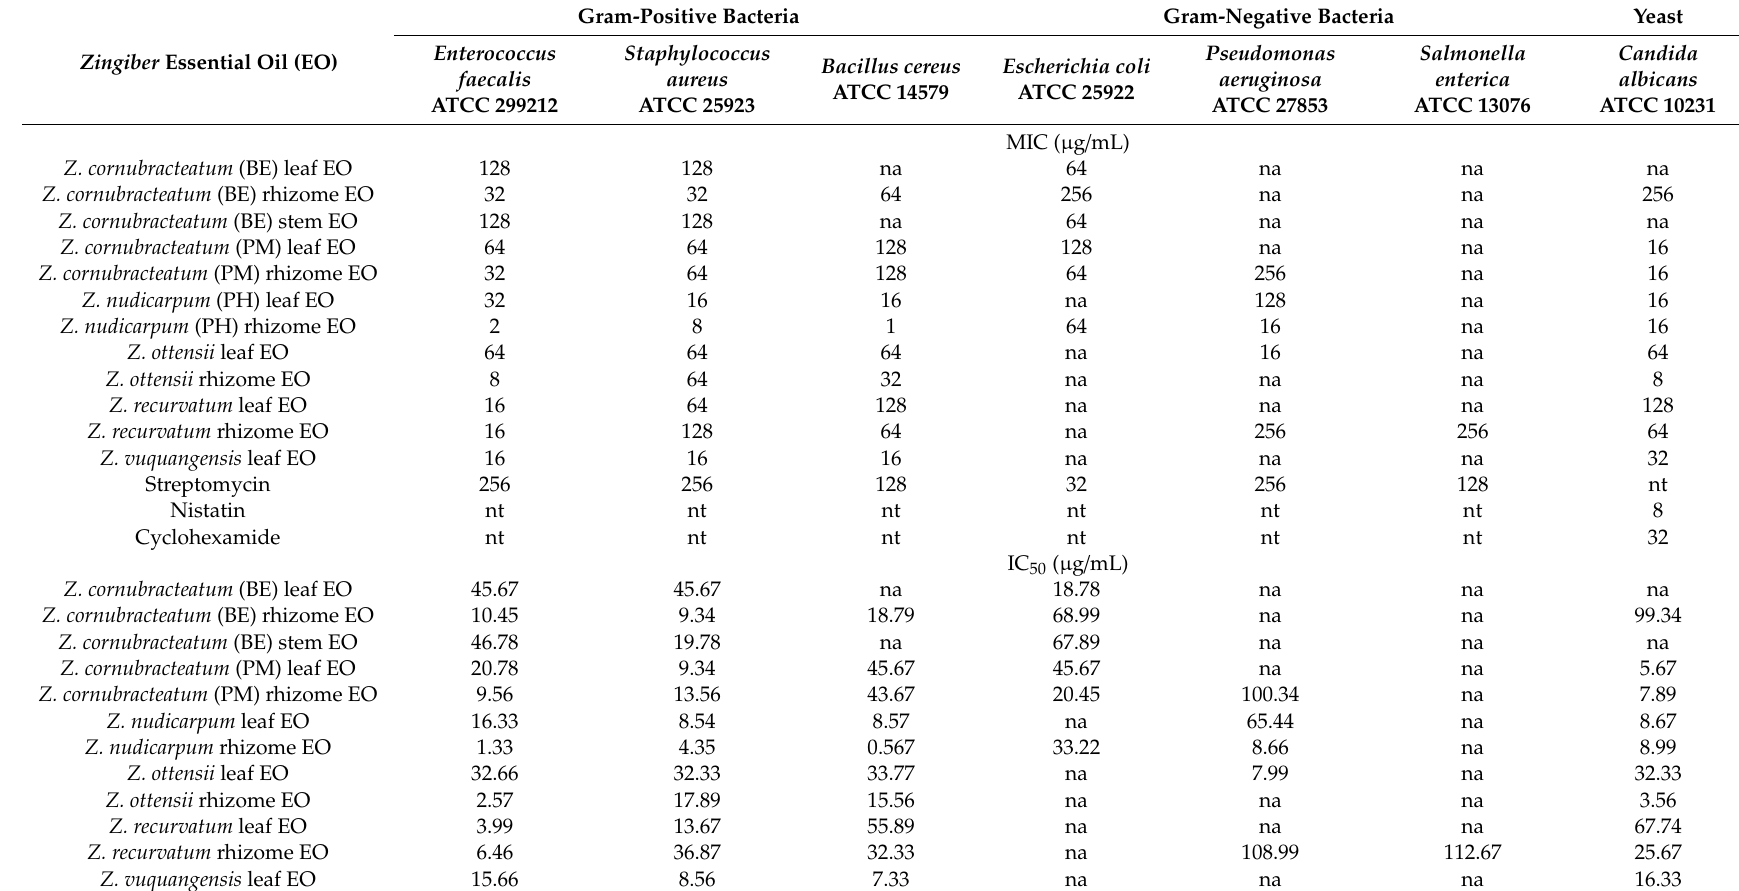
Table 6. Antibacterial and antifungal activities of Zingiber essential oils from north-central